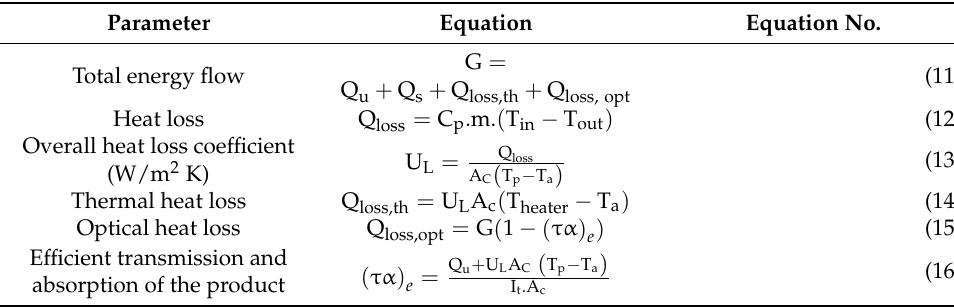
Table 2. Heat loss parameters of the solar air heater,